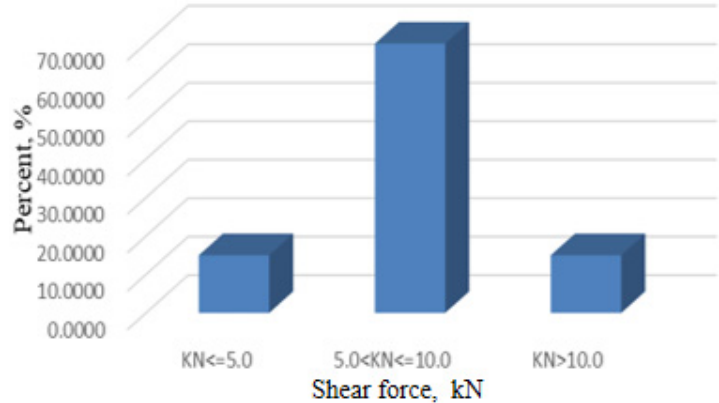
Figure 4. Frequency histogram of shear force range.